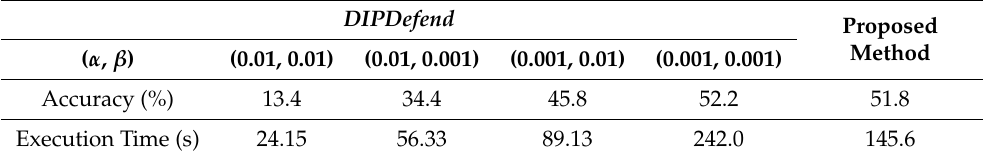
Table 14. Execution time and accuracy of DIPDefend and the proposed method when (cid:101) = 16.